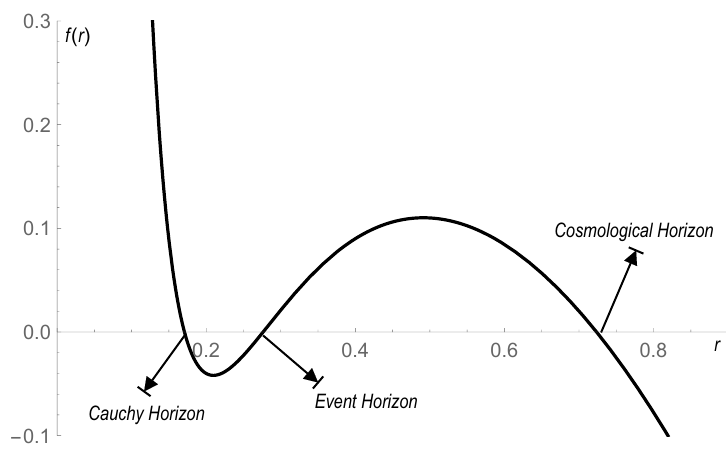
Figure 1 . Four dimensional asymptotically de Sitter black hole, supported by a real, conformally coupled scalar (cid:12)eld, with a (cid:21)(cid:30) 4 potential that is bounded from below. The parameters de(cid:12)ning this solution are (cid:3) = 3, (cid:22) = 0 : 2, (cid:12) 3 = (cid:0) 1 (cid:11) 1 = 1, (cid:12) = 1 and (cid:12) i> 3 = 0. These parameters imply two values for the strength of the scalar (cid:12)eld pro(cid:12)le a (cid:24) : 679 and a (cid:24) 1 : 224 in (6.3), but only the former leads to a potential that is bounded from below (cid:21) (cid:24) : 043 (we have also set 16 (cid:25)G =